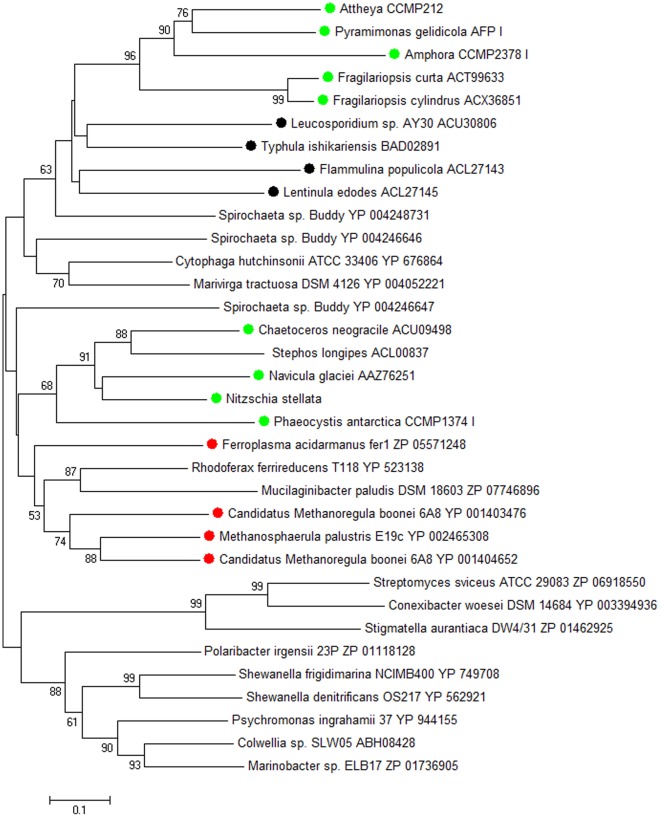
Neighbor-joining tree based on amino acid sequences showing best matches of algal (green symbols) and fungal (black symbols) IBPs.None of the matches except the IBP of the bacterium Colwellia SLW05 have been confirmed to be bona fide IBPs. The tree includes all genes in GenBank that match any of the algal IBPs to within an expect value of 1xe-25. Other than self matching sequences, all nearest matches are of bacterial (unmarked) and archaeal (red symbols) proteins. Numbers at nodes indicate bootstrap values obtained with 500 resamplings. Bootstrap values <50 are not shown. Stephos is a copepod whose IBP appears to have been acquired from Chaetoceros. Accession nos. of IBPs are shown in Table S2.